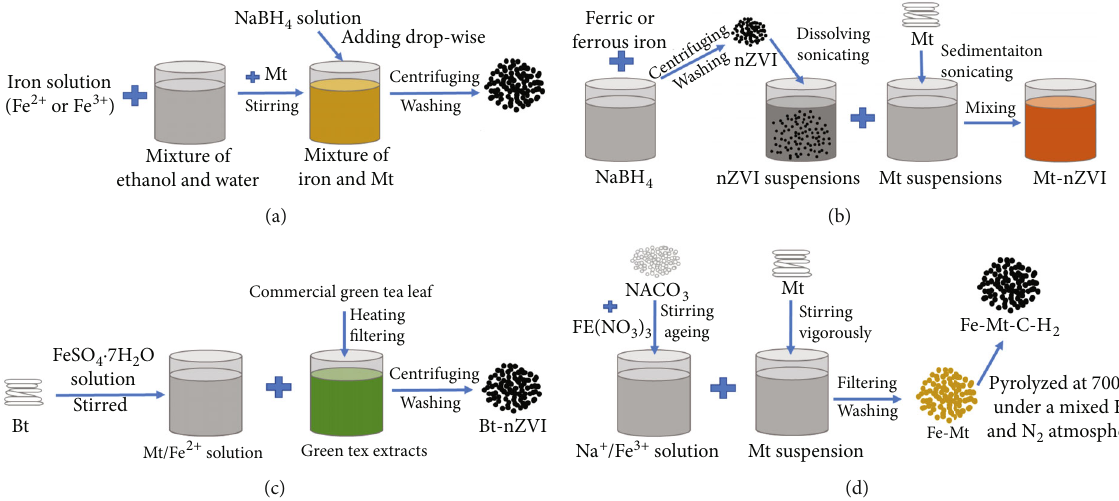
Figure 3: Illustration of the synthesis process of Mt-nZVI by di ff erent methods: (a) liquid-phase reduction; (b) heteroaggregates of Mt with nZVIs; (c) green synthesis method; (d) thermal reduction method.